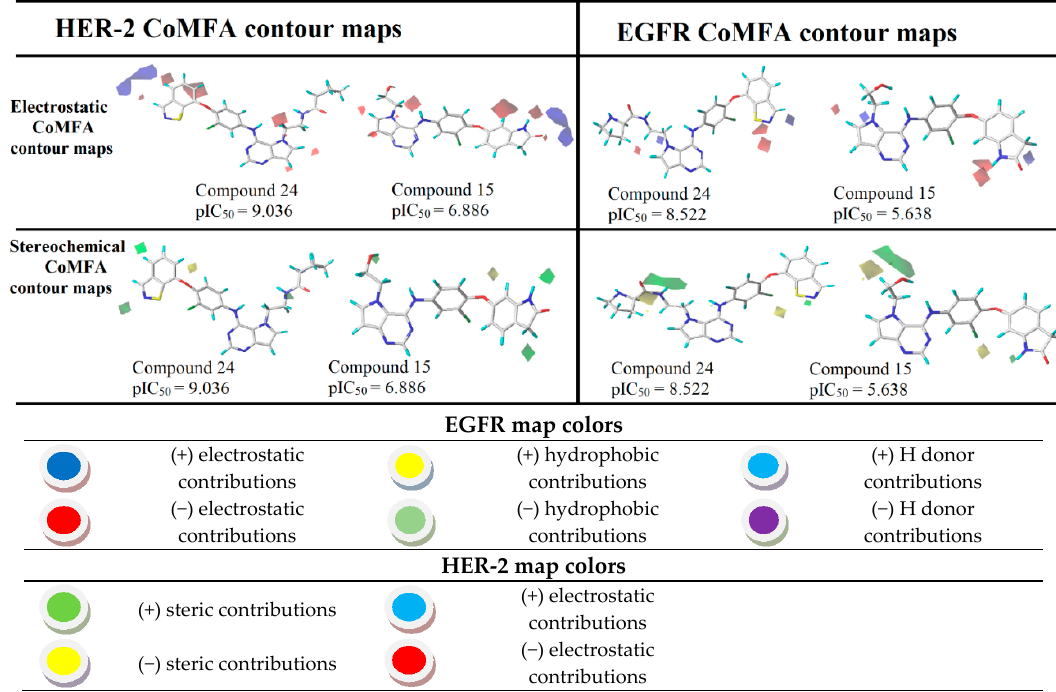
Figure 4. Experimental versus predicted pIC 50 values for the training and test sets obtained from the CoMFA model for both biological targets.